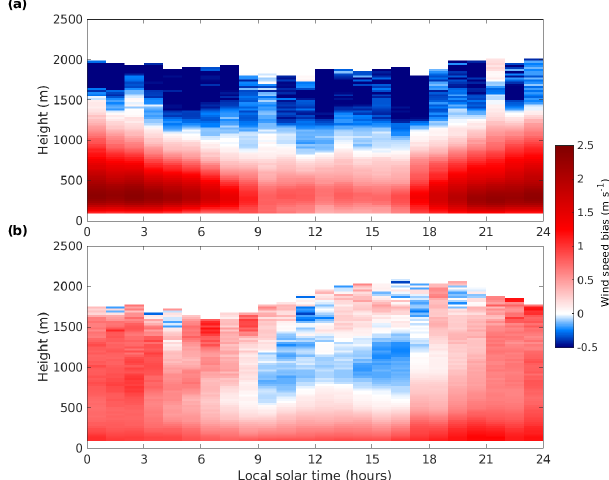
Figure 10. Composites of wind speed bias at SGP for when LLJ (a) is detected and (b) is not detected in the Doppler lidar data. Time refers to approximate local solar